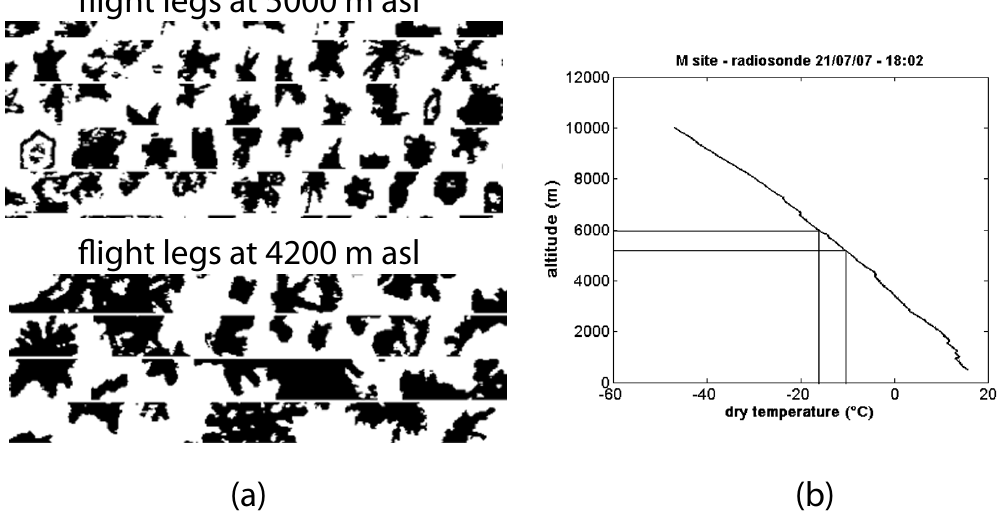
Fig. 12. (a) 2D-C probe images obtained from the ATR42 aircraft flying through the MCS event on 21 July 2007 at the two different flight levels shown in Fig. 11a. (b) Temperature profile obtained from a radiosonde launched at the M site also on the same